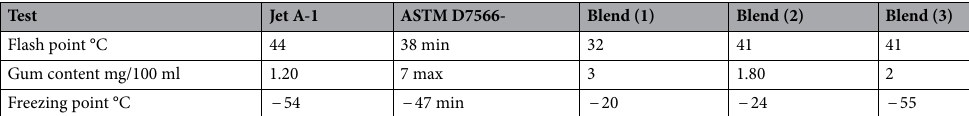
Table 7. Results of physical properties of binary jet fuel A-1 blends with samples of distillate product. *Blend (1): 5% Distillate product sample (95%) in range (140–280° C) + 95% Bio-jet A-1. Blend (2): 5%